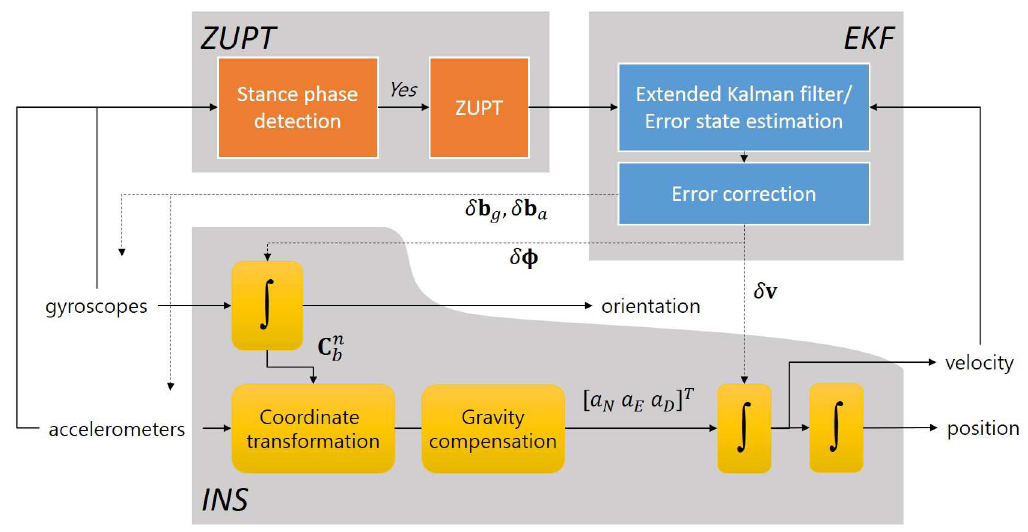
Figure 2. INS-EKF-ZUPT algorithm flow